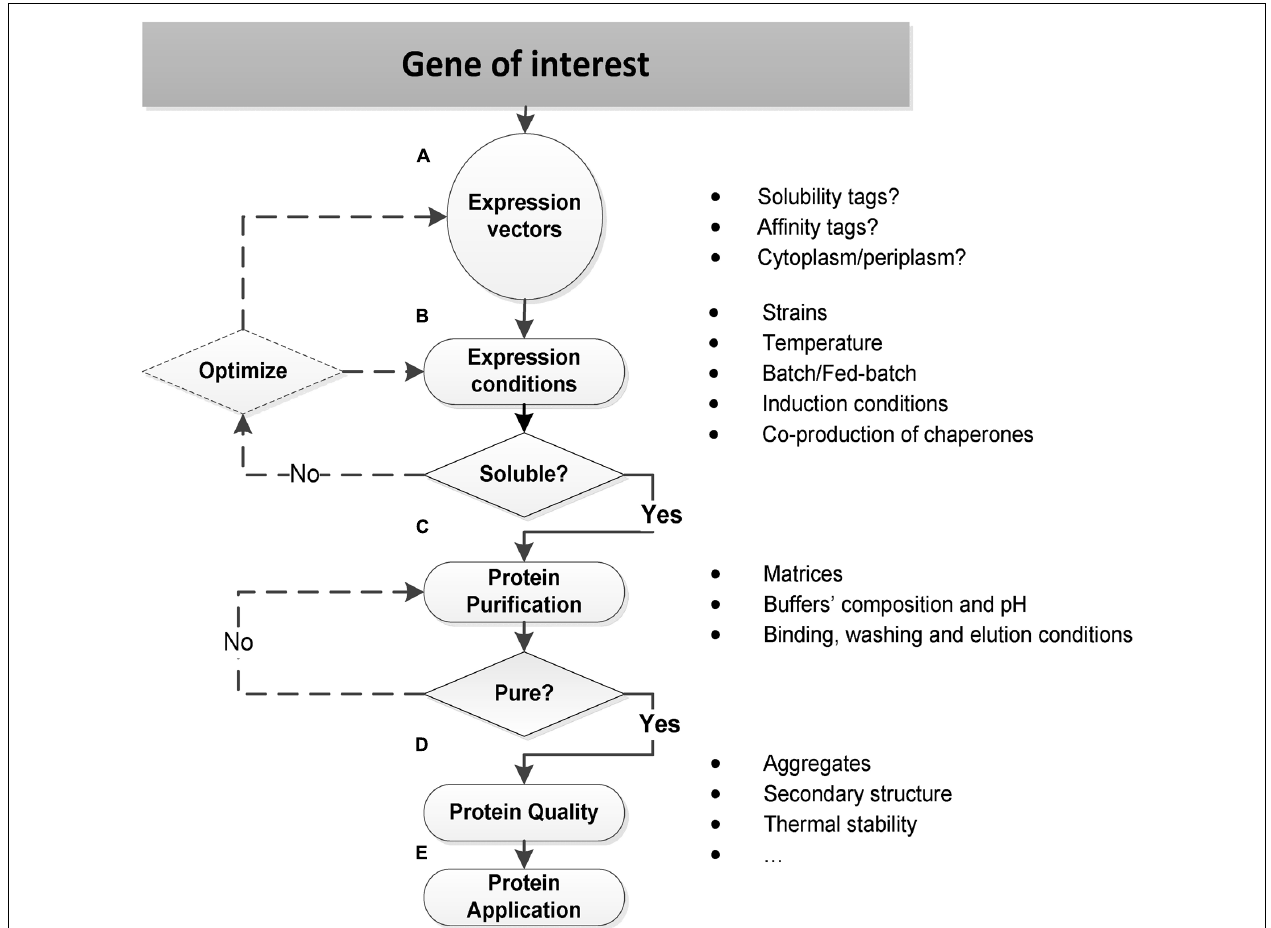
defined at the beginning when selecting the expression vector: if an affinity tag is incorporated, then a first affinity chromatography step should be conducted. On the other hand, if an affinity tag is prohibit, other strategies, namely, ion exchange, size exclusion, or hydrophobic interaction chromatography should be tested. After the first purification step, the TP may or may not be sufficiently pure. When it is not pure, further purification steps with other chromatographic strategies need to be conducted. (D–E) The protein quality is an essential requirement for many structural and functional application studies: a purified soluble protein may be aggregated, without a defined secondary structure, and it may also present a low thermal stability. Therefore, a biophysical characterization is often required before proceeding to the final protein’s